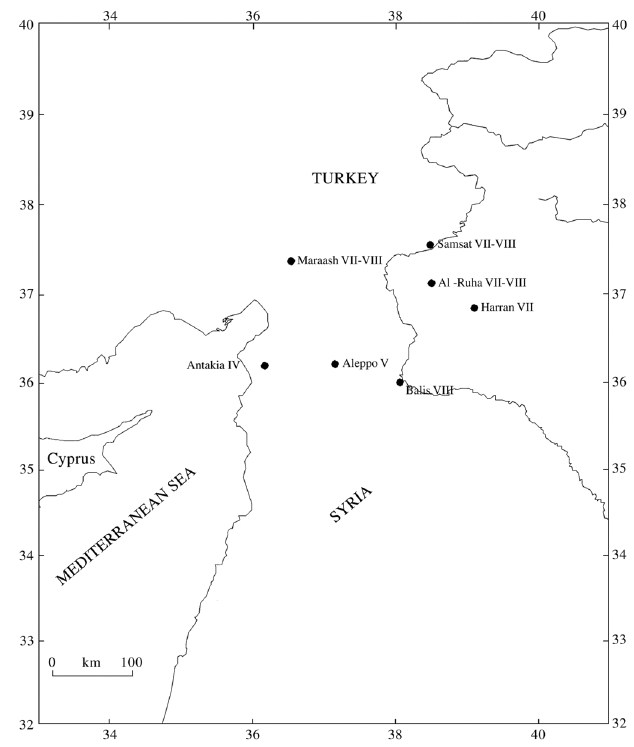
Fig. 8. Map of intensity distribution for November 1114